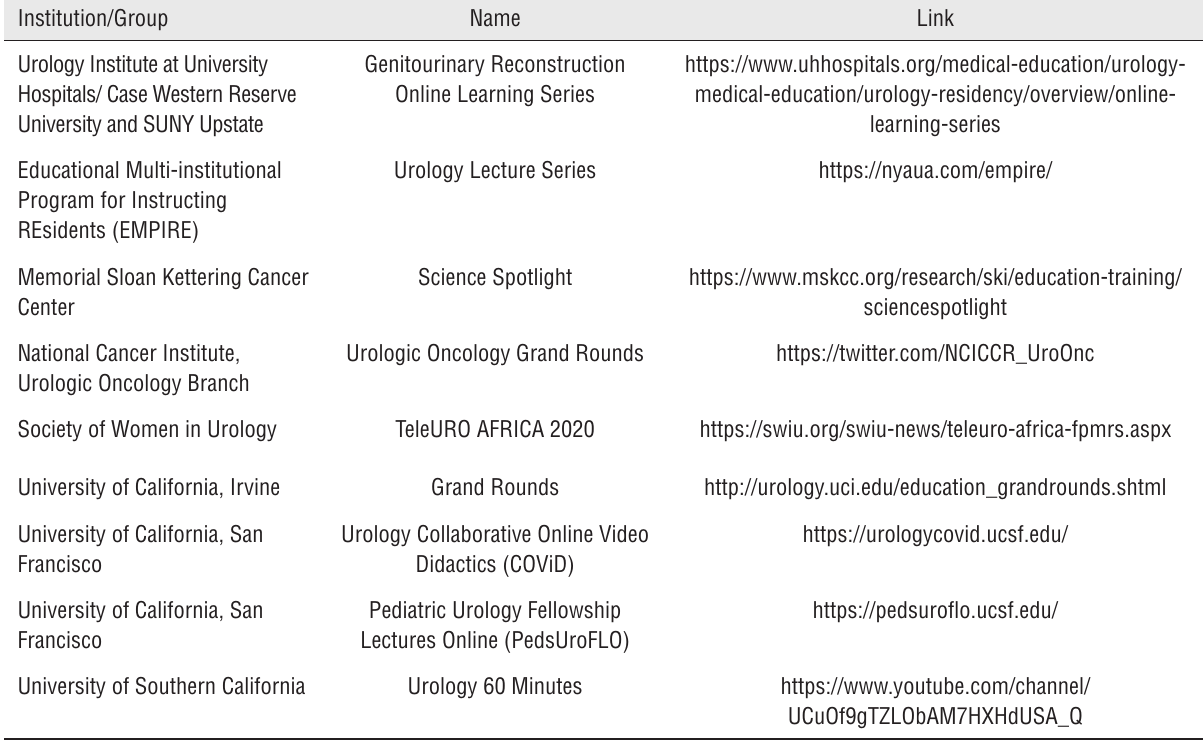
Table 2 - List of available free lecture series. Institution/Group Name